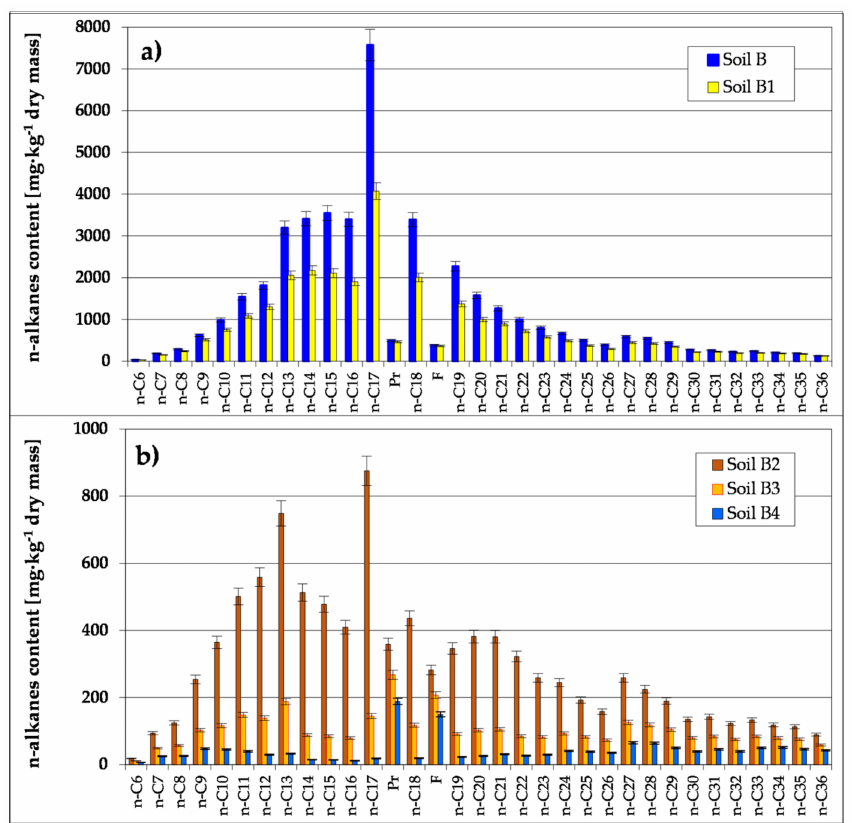
Figure 1. Comparison of identified n-alkane contents in Soil B: ( a ) after basic bioremediation; ( b ) after successive series of inoculations in laboratory conditions—ex-situ method (repetition number n = 9–10 p < 0.05). (Soil B) raw soil; (Soil B1) soil after basic bioremediation; (Soil B2) soil after inoculation with I biopreparation (1st series); (Soil B3) soil after inoculation with I biopreparation (2nd series); (Soil B4) soil after inoculation with II biopreparation (3rd